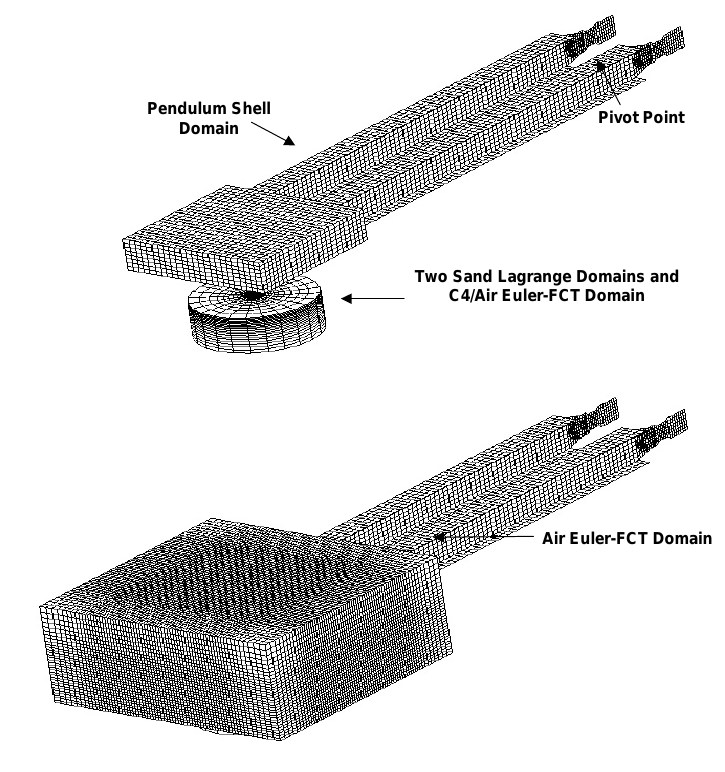
Fig. 3. Various Computational domains used in the present non-linear dynamics